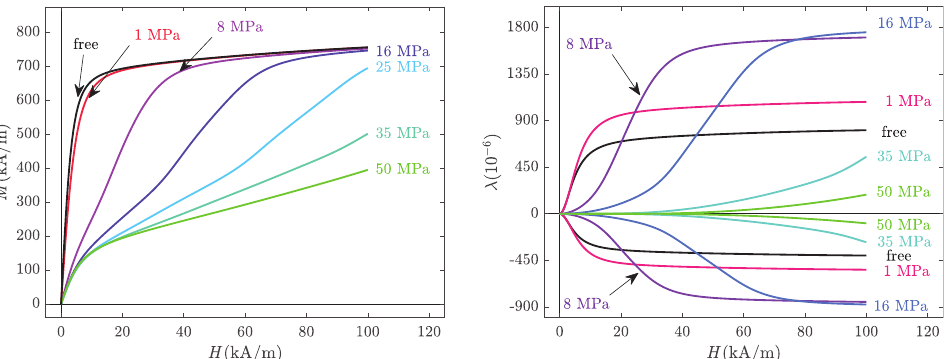
Figure 4. Anhysteretic magneto-elastic behaviour: magnetisation ( left ) and magnetostriction strain ( right ) at various levels of compressive stress. Modelling results from the full multiscale